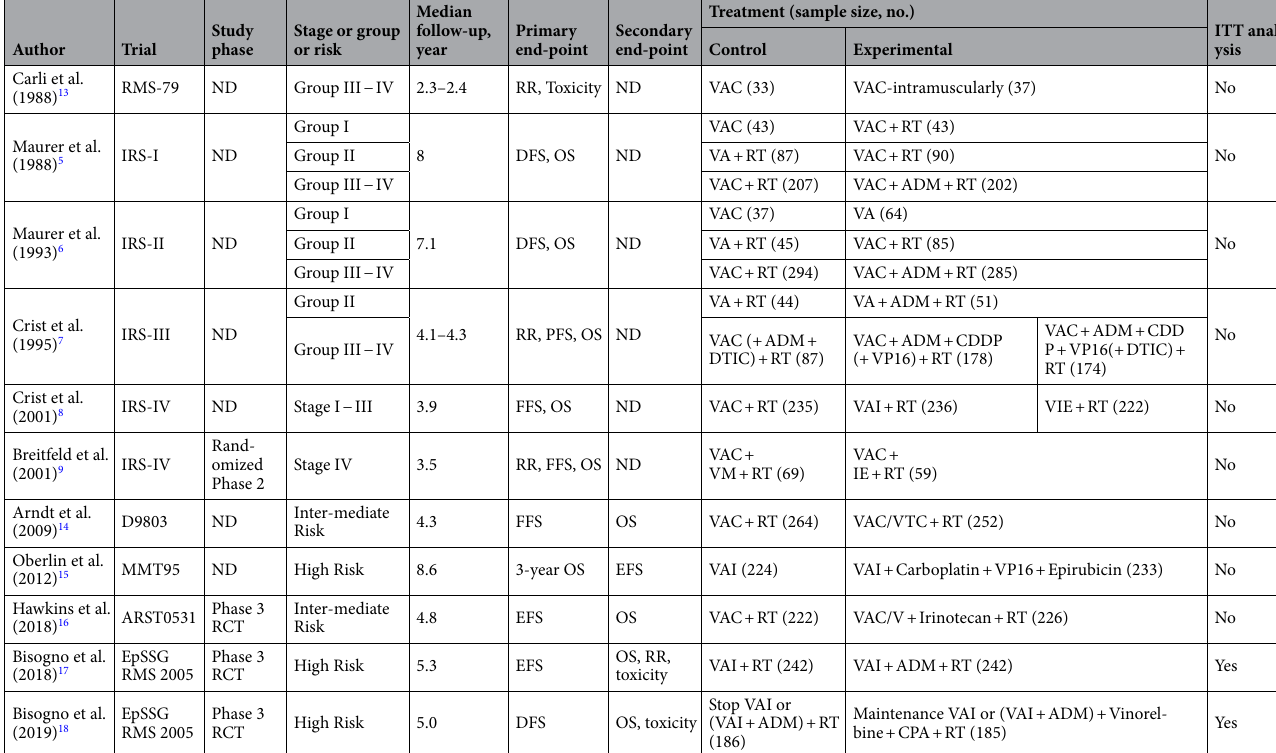
Table 1. Characteristics of included randomized control trials. Abbreviations: A, dactinomycin; ADM, adriamycin; C, cyclophosphamide; CDDP, cisplatin; CPA, cyclophosphamide; DFS, disease-free survival; DTIC, dacarbazine; E, etoposide; EFS, event-free survival; EpSSG, the European paediatric Soft tissue sarcoma Study Group; FFS, failure-free survival; I, ifosfamide; ITT, intention-to-treat; IRS, the intergroup rhabdomyosarcoma study; M, melphalan; MMT, malignant mesenchymal tumor; ND, not described; OS, overall survival; RCT, randomized controlled trial; RMS, rhabdomyosarcoma; RR, response rate; RT, radiotherapy; T, topotecan; V, vincristine; VP16,